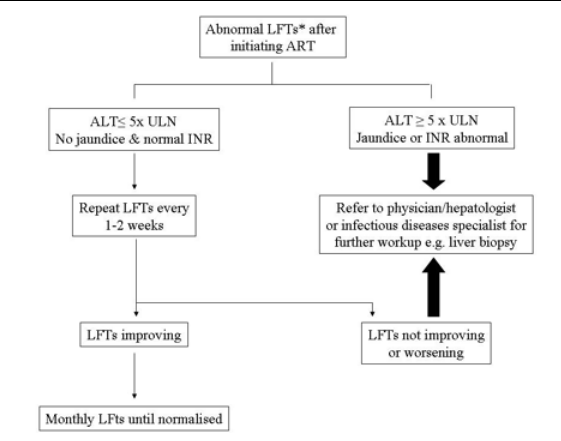
Fig. 2. Clinical approach to management of HIV-HBV co-infected patients who develop liver dysfunction on